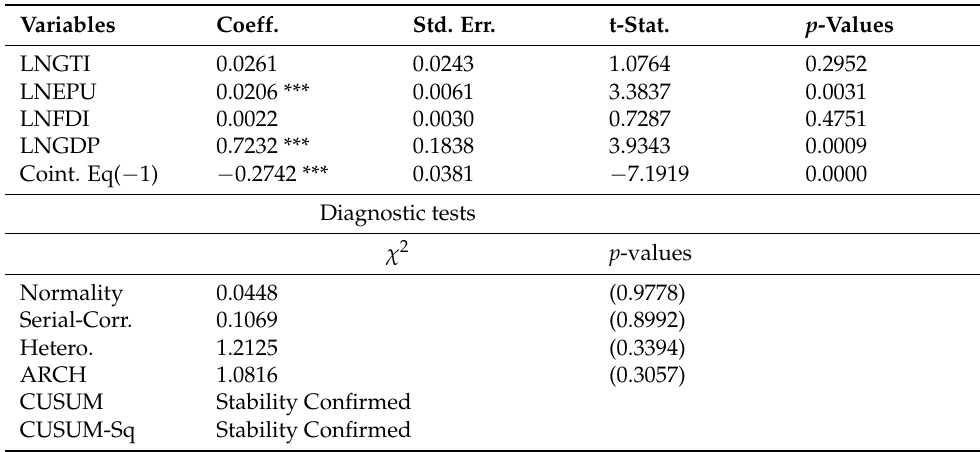
Table 9. ARDL short-run